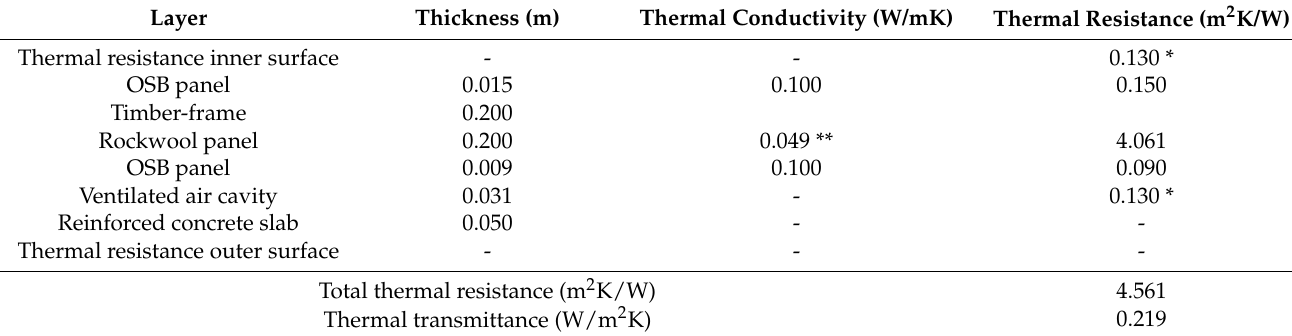
Table 5. Thermal transmittance calculation for the opaque ventilated façade following UNI EN ISO 6946. Layer Thickness